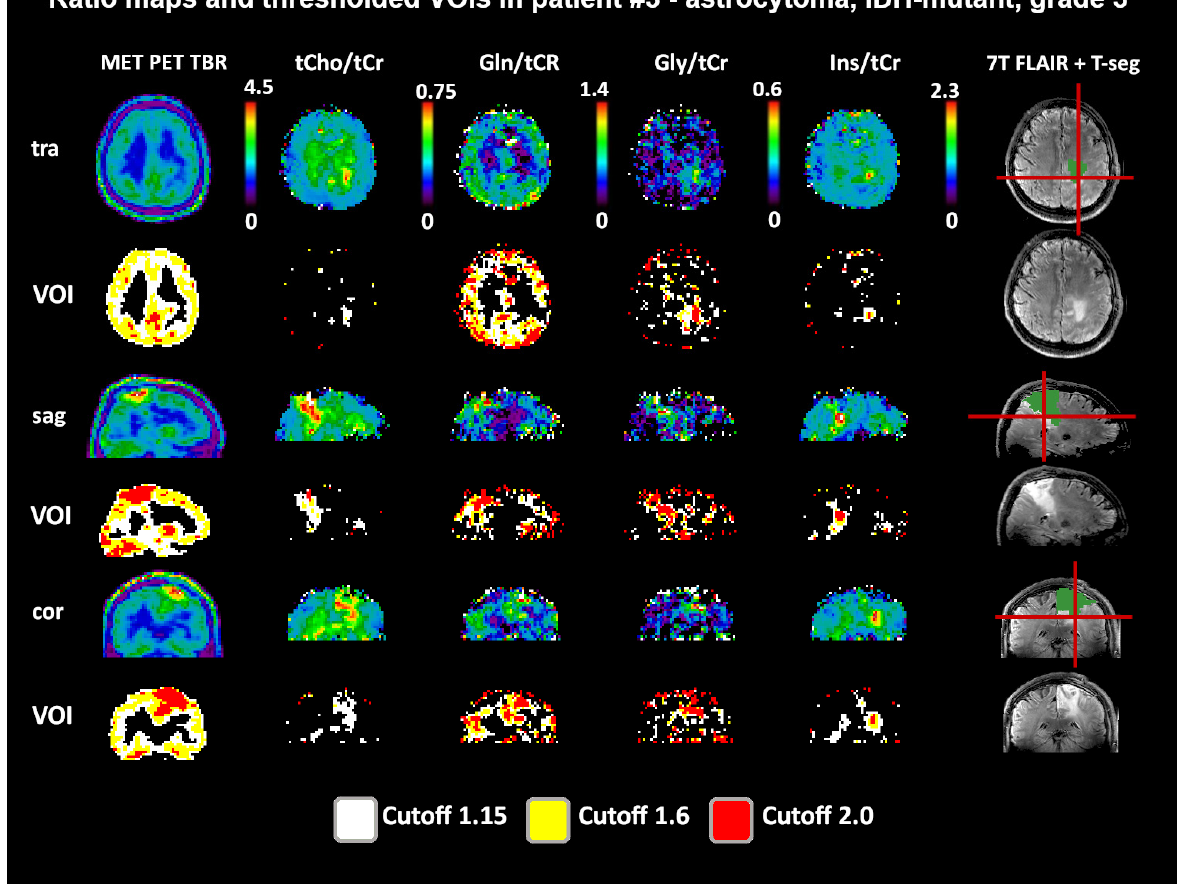
Figure 5. Example images of a patient with a low-to-moderate intratumoral correspondence between PET and MRSI ratios to tCr. While Gln/tCr and Gly/tCr align most directly with MET (DSCs for TSEG1.6: 0.59 and 0.55), tCho/tCr extends clearly beyond (DSC for TSEG1.6: 0.25), and Ins/tCr is located only more basally (DSC for TSEG1.6: 0.13). The actual evaluation as performed only within the defined tumor segmentations is shown in green. PET maps were resampled to MRSI